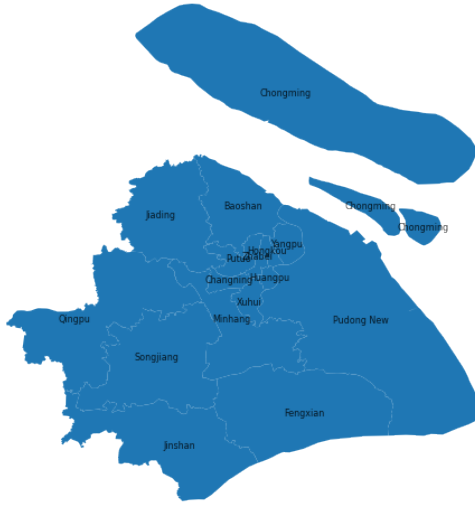
Figure 5: Spatial distribution of all administrative divisions of Shanghai